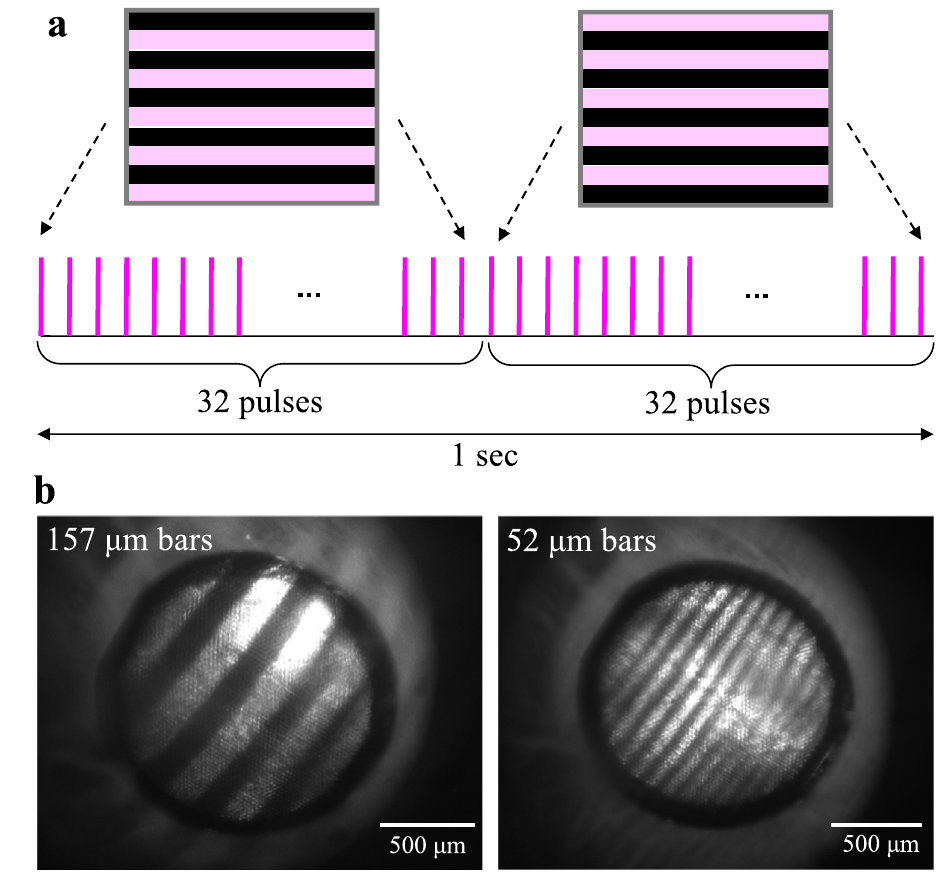
Fig. 6 | Measurement scheme ofthe grating acuity. a Projected grating patterns alternate at2Hz, pulsed at a carrier frequencyof 64Hz, with a pulse duration of4ms. b Images of the projected gratings with bar widths of 157 and 52 μ m, respectively, on a 20 μ m implant in a rat